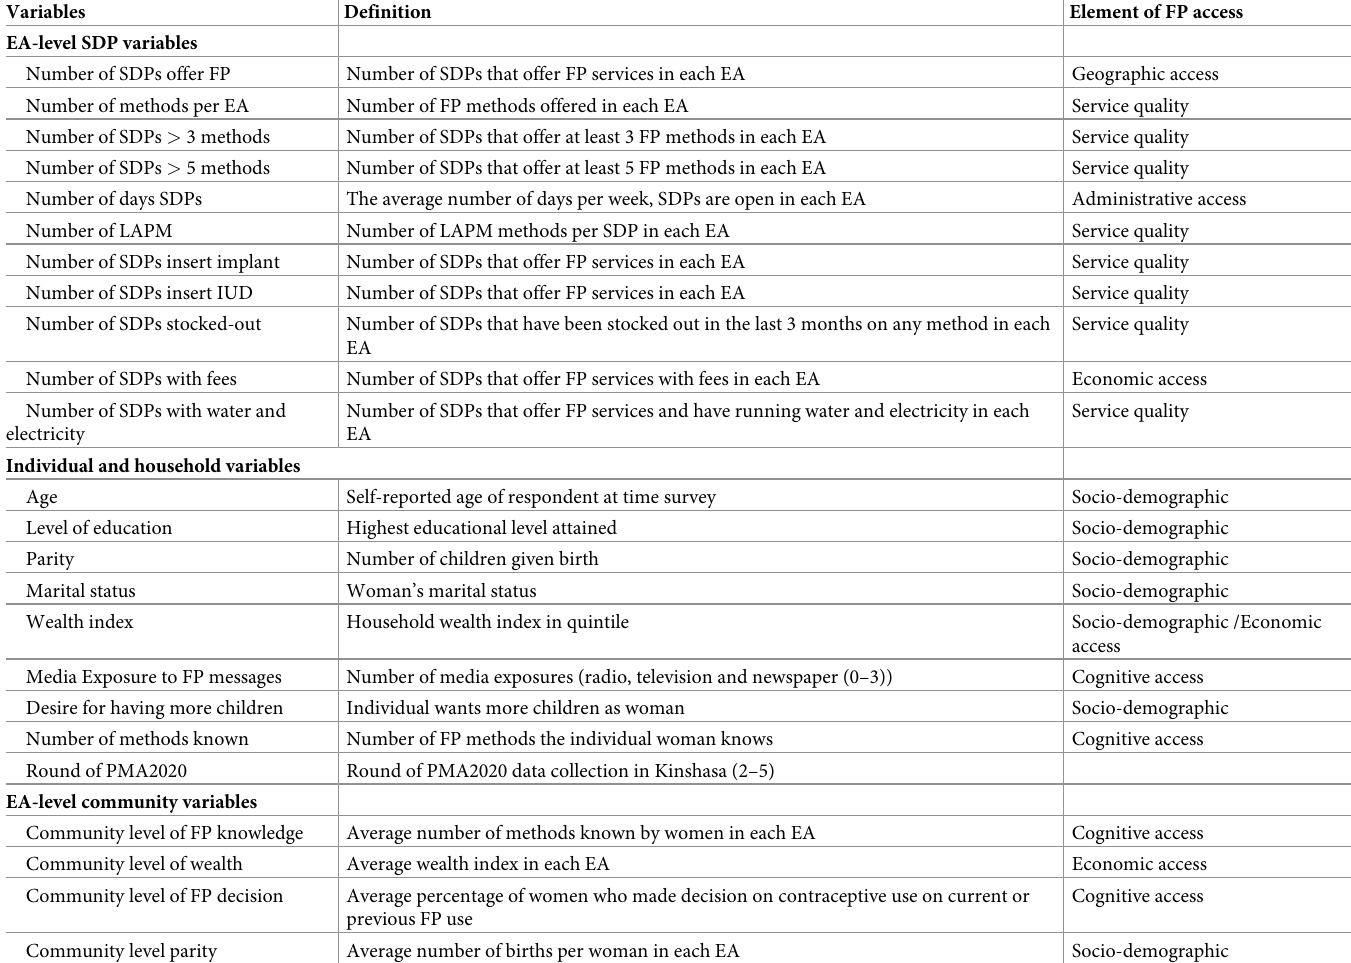
Table 1. Variables representing elements of access to family